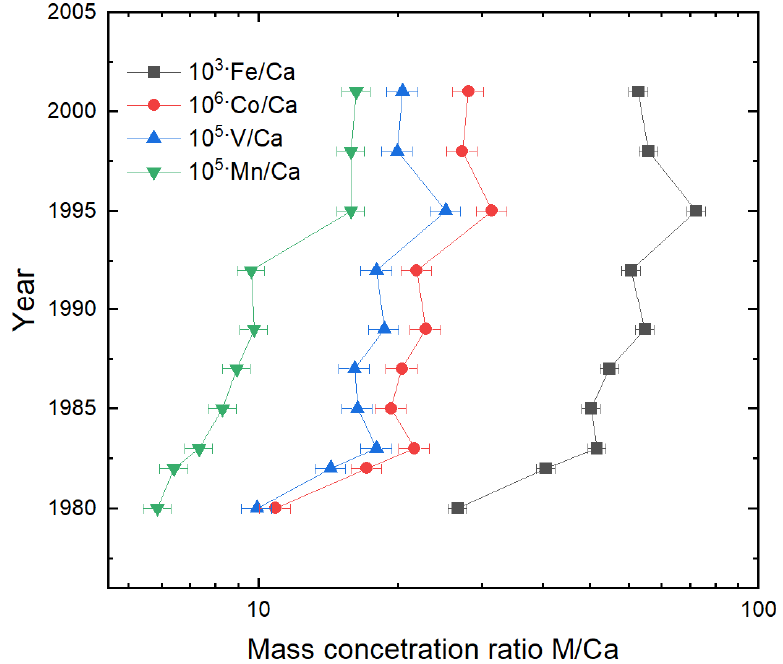
Figure 6. Mass concentration ratios of redox-sensitive elements (M): V, Mn, Fe and Co in relation to Ca (as the main constituent of the Korana tufa) in